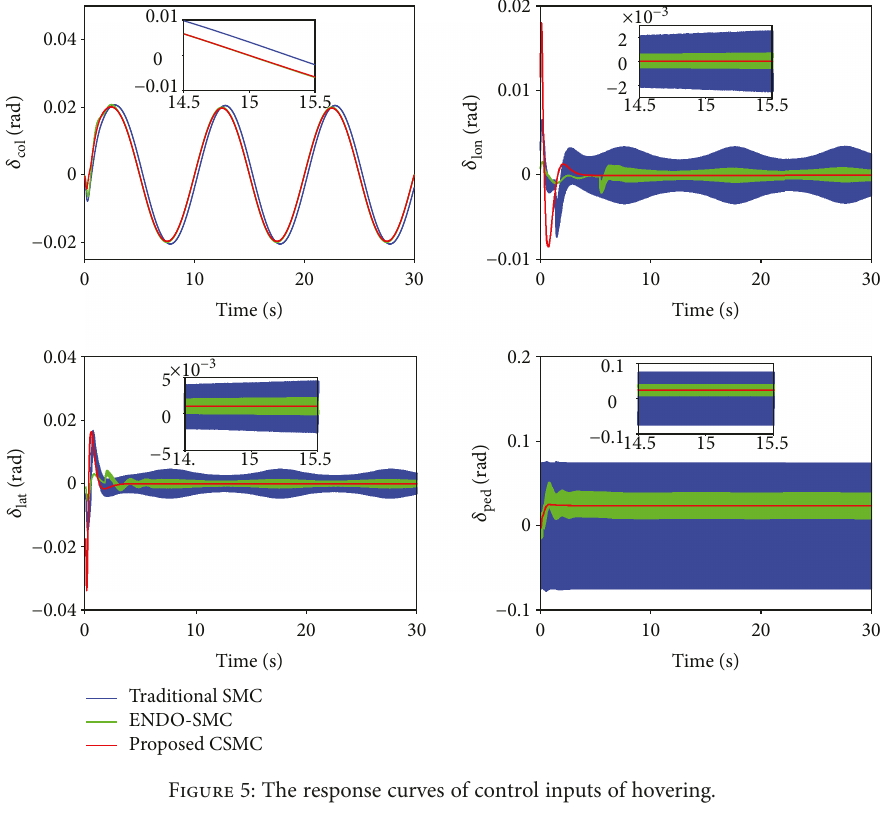
Figure 5: The response curves of control inputs of hovering.